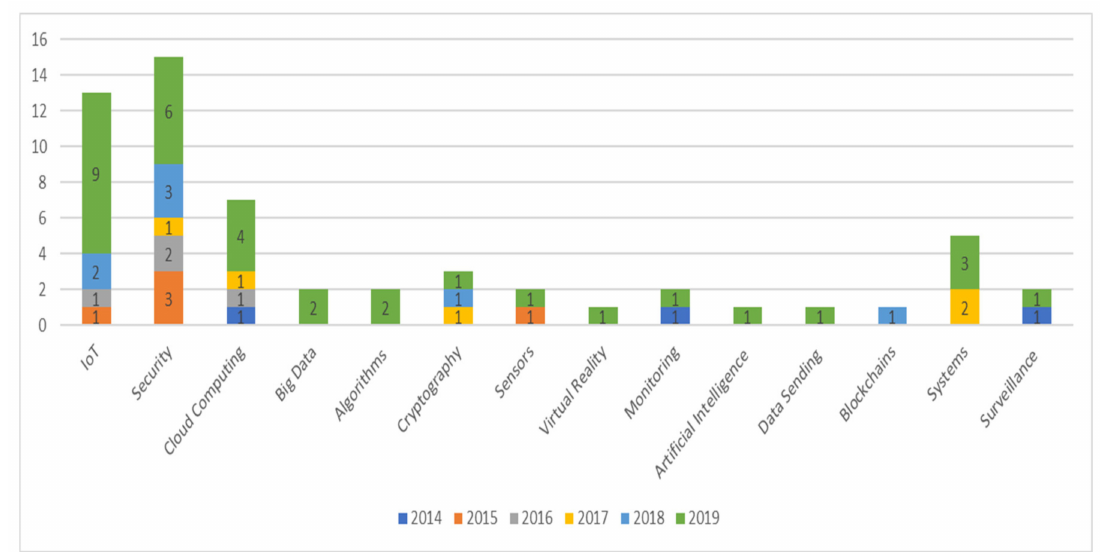
Figure 5. Number of publications in articles combining technology and